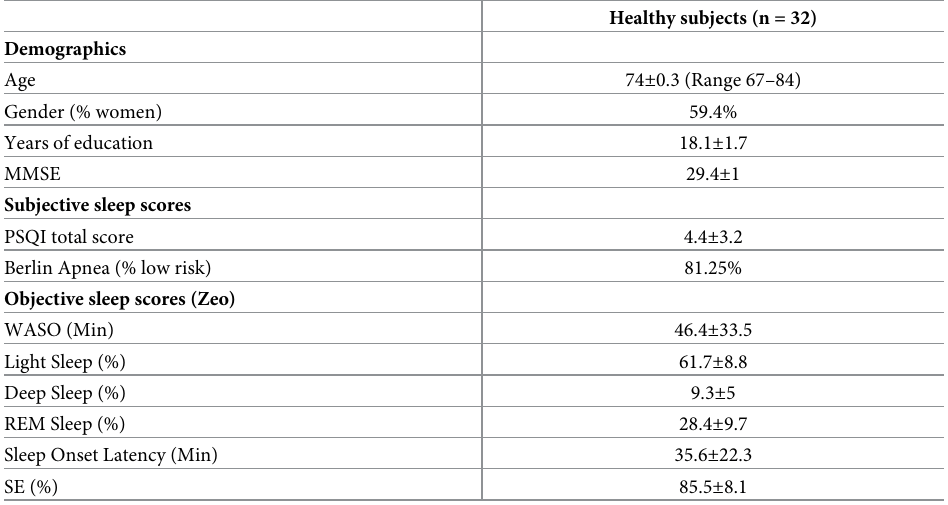
Table 1. Demographics and subjective sleep scores.